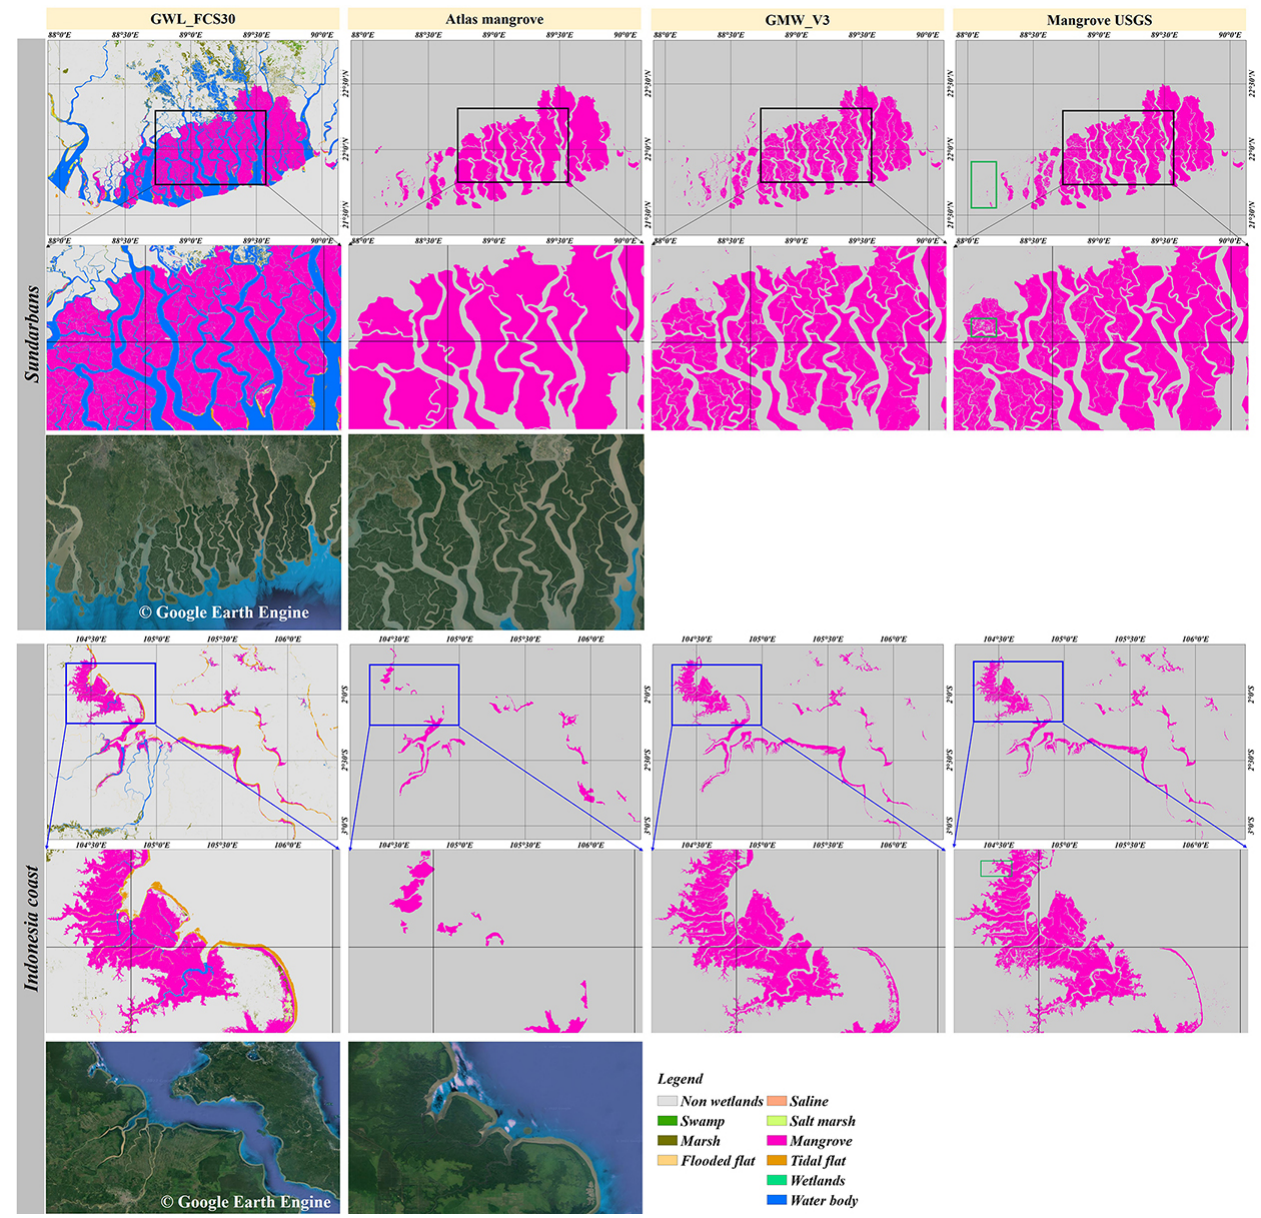
Figure 14. The cross-comparisons between our GWL_FCS30 wetland maps with three mangrove products (Atlas mangrove developed by Spalding, 2010; GMW_V3 developed by Bunting et al., 2022; Mangrove USGS developed by Giri et al., 2011) in Sundarbans and coastal Indonesia. The high-resolution imagery comes from the © Google Earth Engine platform (https://earthengine.google.com; last access: 16 May